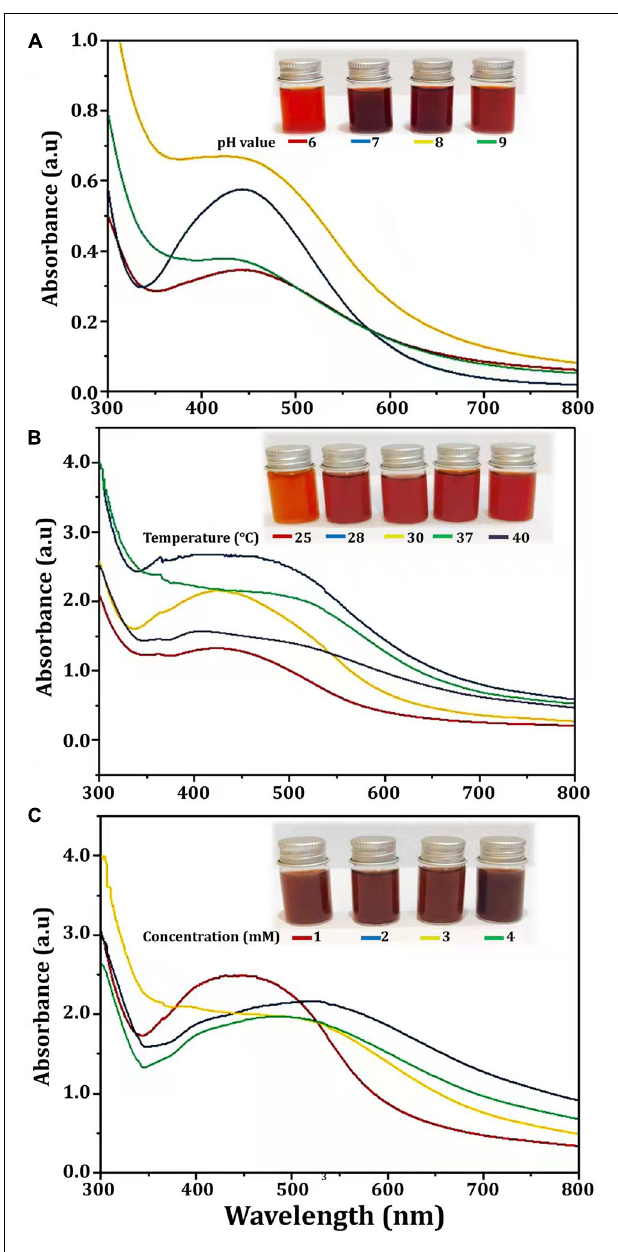
FIGURE 4 | UV-visible spectra of Bio-AgNPs obtained at different reaction conditions. (A) Different pH value of reaction mixture, (B) Different reaction temperature ( ◦ C), (C) Different concentration of AgNO 3